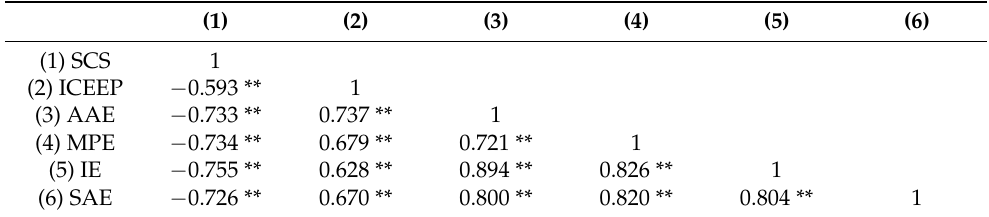
Table 2. Correlation analysis of values (n =